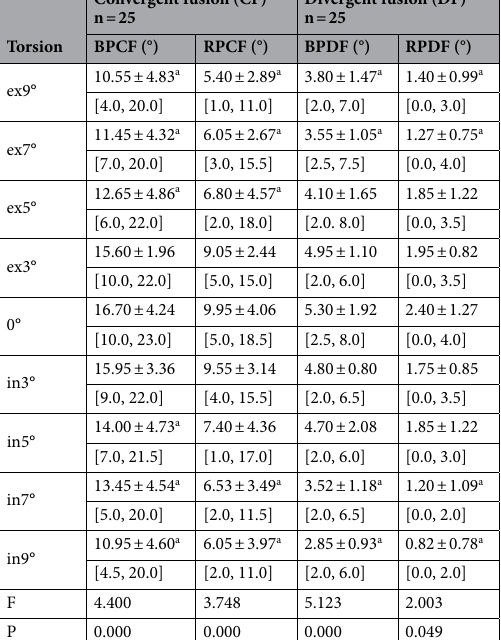
Table 3. BPCF, RPCF, BPDF and RPDF of f-F at different rotations. ex, extorsion; in, intorsion. a P < 0.05 comparison with the value in the baseline (0°) by Tukey’s multiple comparison